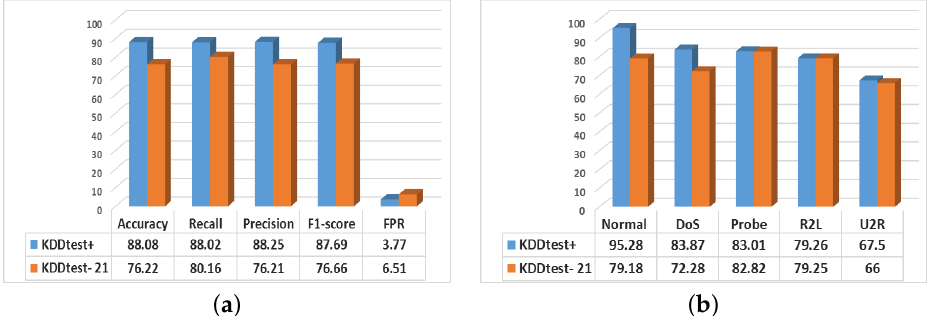
Figure 6. The intrusion detection performance (in %) of our proposed CFLVAE-DNN model. ( a ) Over- all performance; ( b ) Class-wise detection